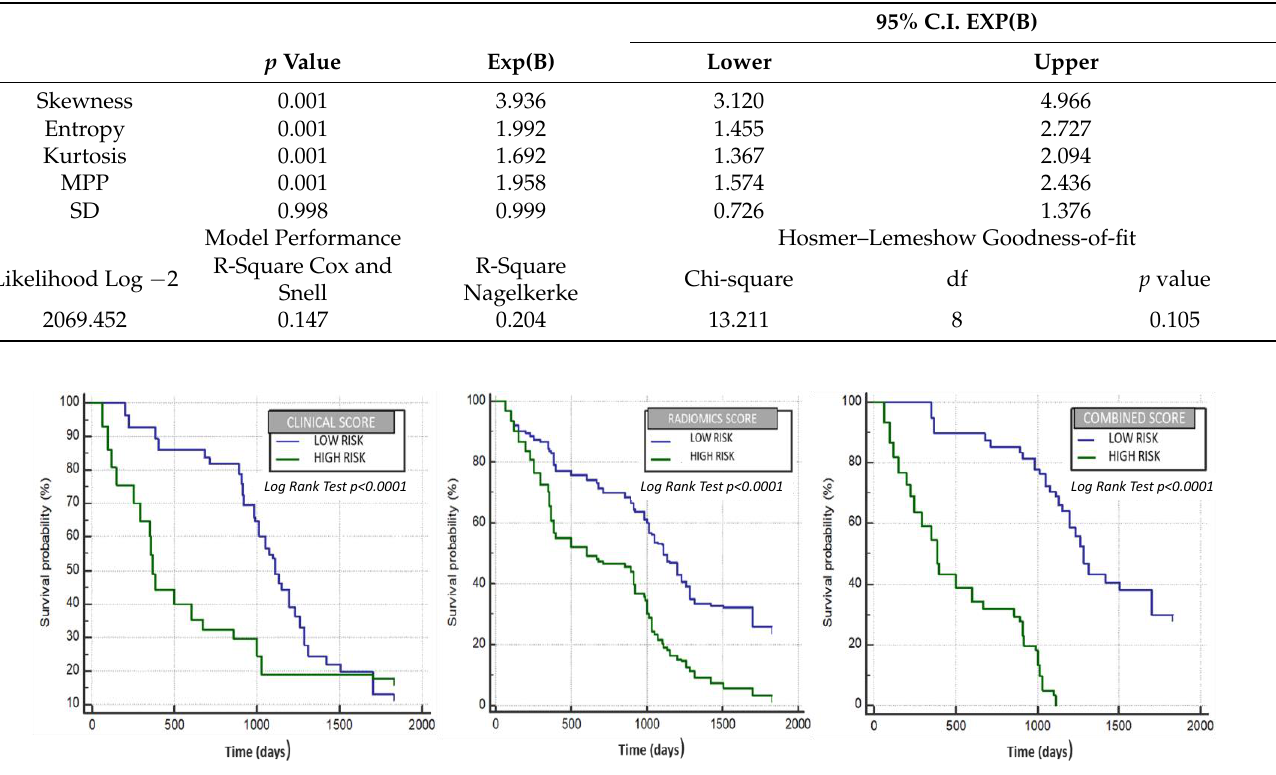
Figure 2. Clinical variables, radiomic features and combined clinical and radiomic features model performance in evaluat- ing